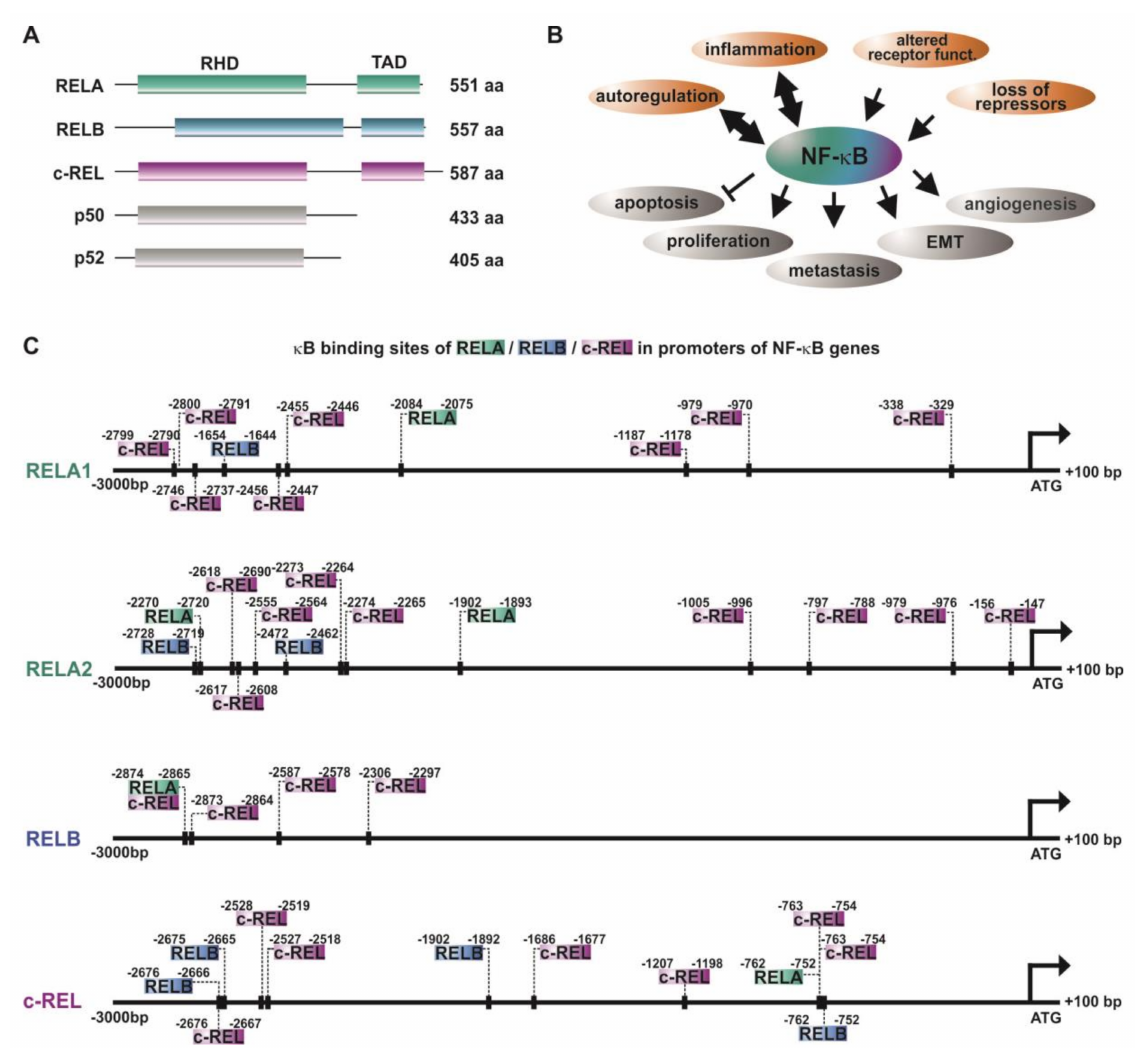
Figure 1. NF- κ B and autoregulation of NF- κ B subunits in cancer. ( A ) Schematic view of the NF- κ B-family ([11]). ( B ) Principal mechanisms causing overexpression/activation of NF- κ B as well as the cellular effects of NF- κ B acitivity leading to cancer development and progression. RHD: